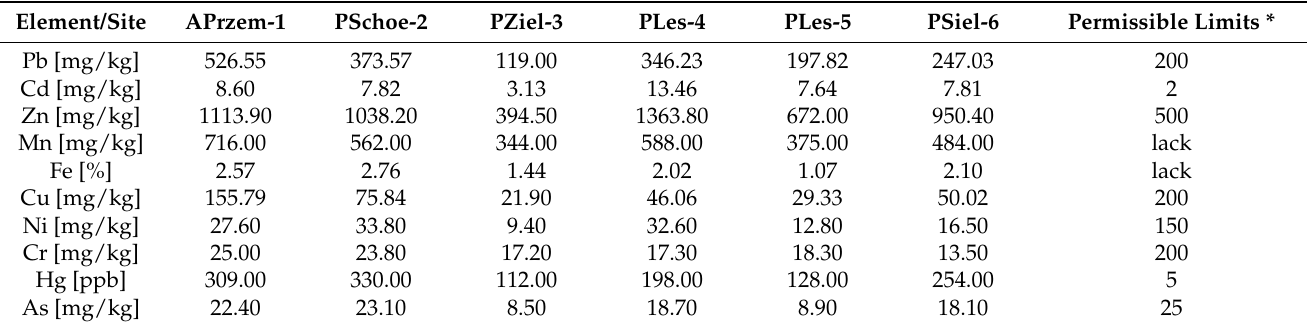
Table 4. The content of heavy metals in topsoil under Ch. majus